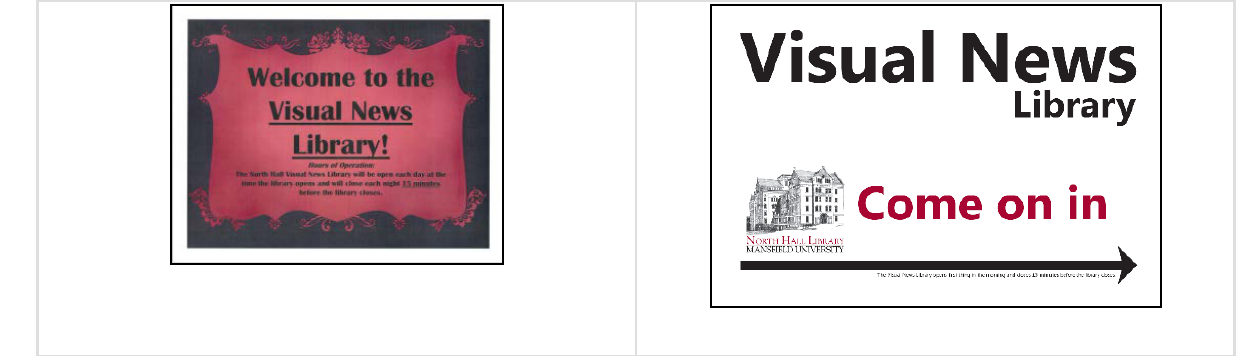
The original sign (left) pointing to the reference desk has limitations because of the all-caps font, the decorative font, the color choice, the small font size, and the lack of contrast. The new sign (right) is twice the size and uses contrast to draw attention to the purpose of the sign. Non-centered alignment creates more visual interest and movement, helping to keep the patrons’ attention and point them in the proper direction.